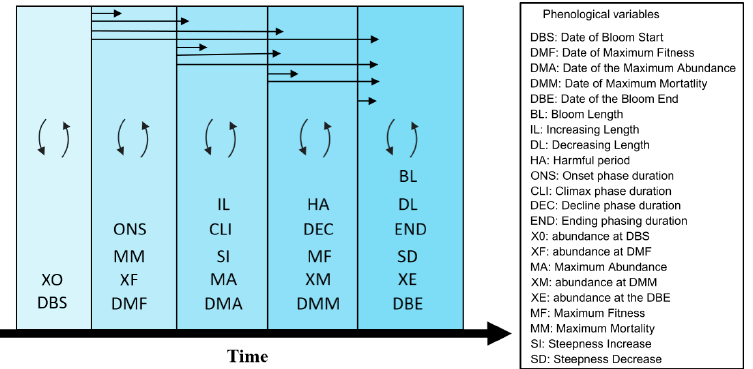
Figure 3. Summary of the relationship between phenological variables according to their respective timing of appearances. The blue boxes regroup the variables appearing at the same point in time. The straight black arrows represent the relationships between the variables of one box to another. The curves represent the relationships between the variables found within each